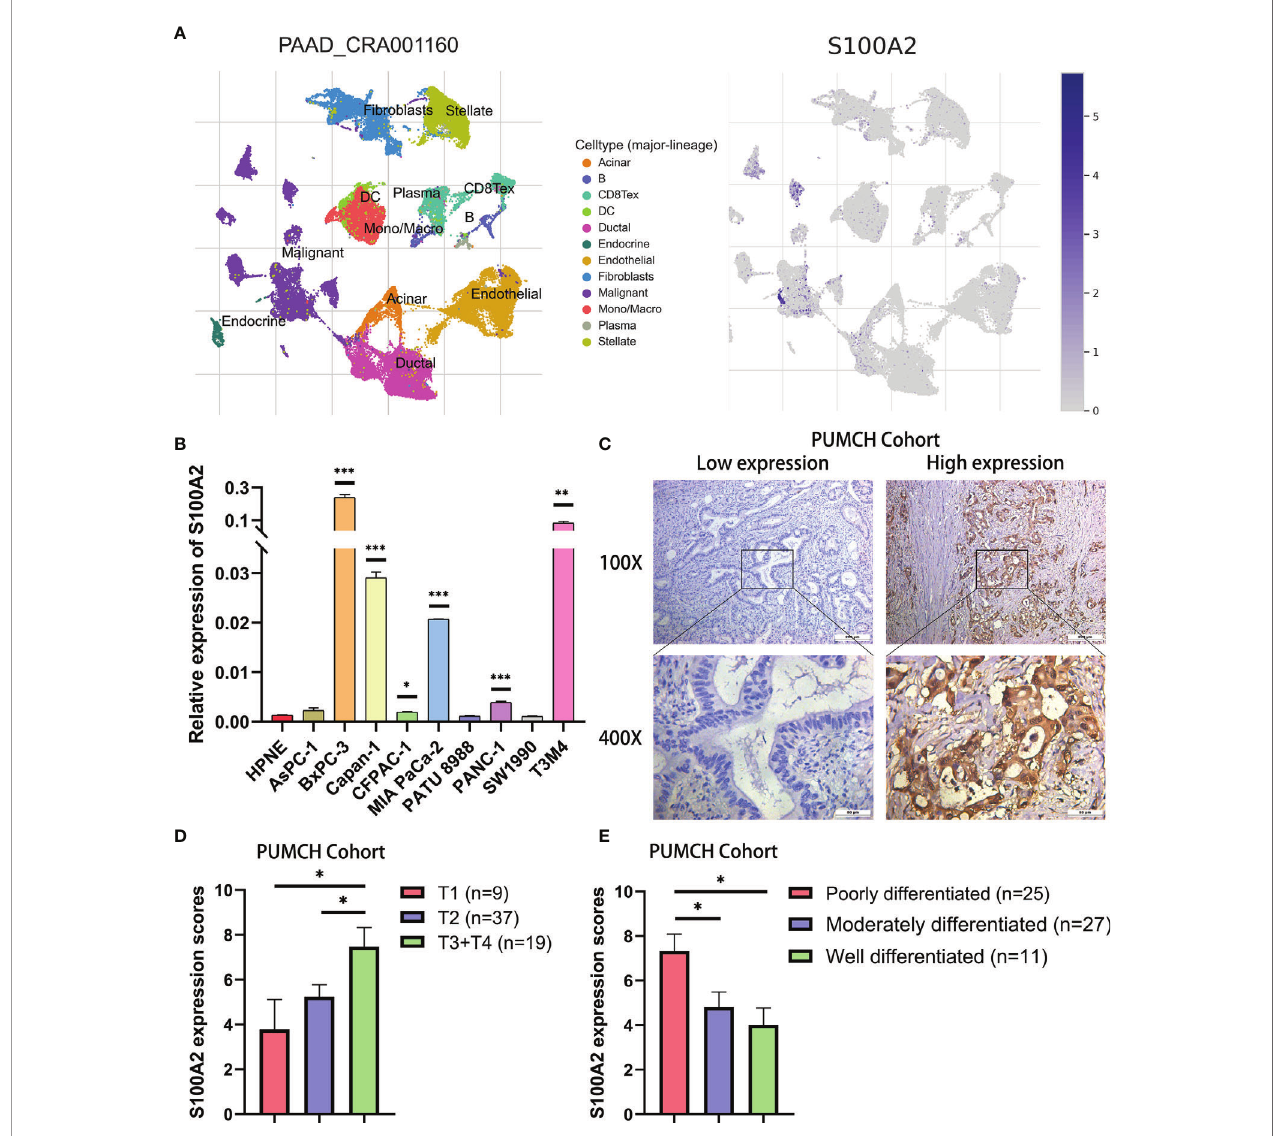
FIGURE 5 | Validation of high expression of S100A2 in PC cancer cells and its association with poor prognosis. (A) The results of clustering and S100A2 expression distribution in single cell dataset CRA001160. (B) The expression difference of S100A2 between normal and pancreatic cancer cell lines detected by qRT-PCR. The difference between each PC cell line and HPNE was analyzed. (C) Representative images of low and high expression of S100A2 in PUMCH cohort (n = 65). (D – E) Correlation between S100A expression and T stage and differentiation status in PUMCH cohort. *P < 0.05; **P < 0.01; ***P <